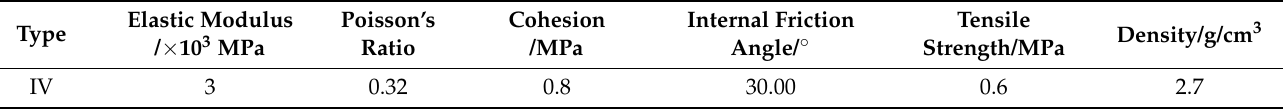
Table 20. Site Class IV enclosure parameters of IV.